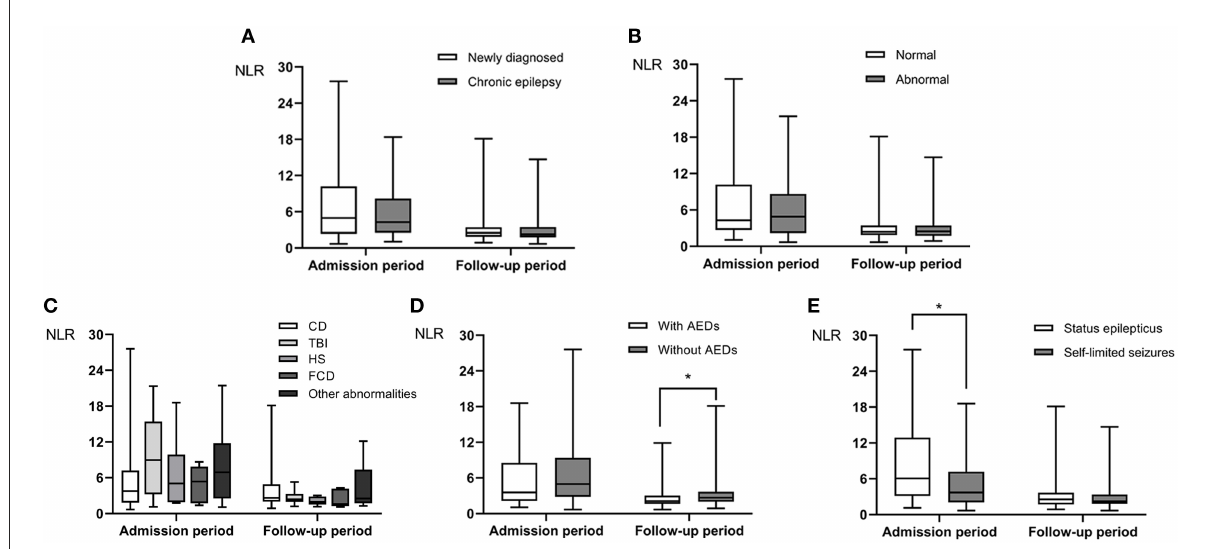
FIGURE2 The difference in NLR levels at admission (NLR1, within 24h of acute seizure) and follow-up period (NLR2, 5–14 days after admission) in PWE. Neither NLR1 nor NLR2 level was different between patients with newly diagnosed epilepsy and those with chronic epilepsy (A) . There was no significant difference in NLR level between patients with idiopathic epilepsy and those with secondary epilepsy (B) , and there was no significant difference in NLR level among the five categories of patients with focal epilepsy (C) . NLR2 level in patients on treatment with ASDs was lower than those in patients on no treatment with ASDs (D) . NLR1 level in patients with SE was higher than that in patients with self-limited seizures (E) . Group comparison was done by Mann-Whitney U test. * P < 0.05.